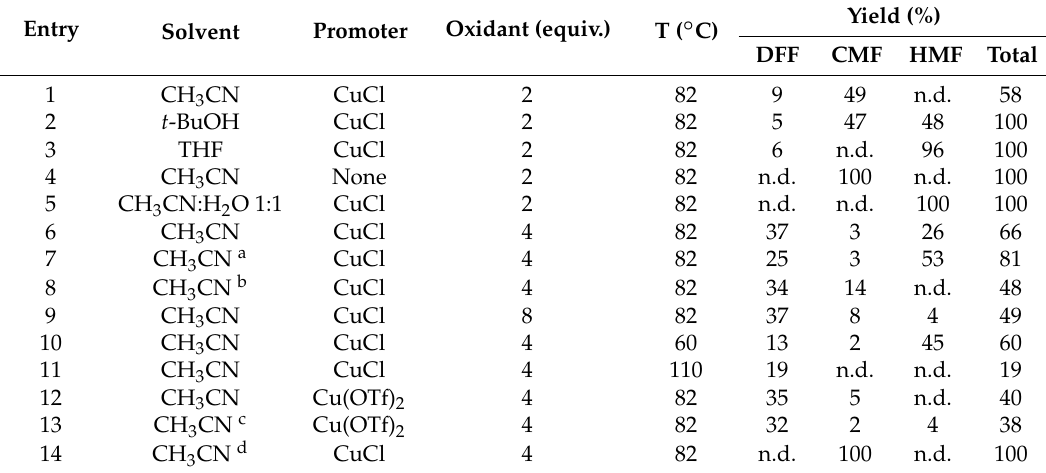
Table 1. Optimization of reaction conditions for the oxidation of CMF using PNO as an oxidant under thermal heating.